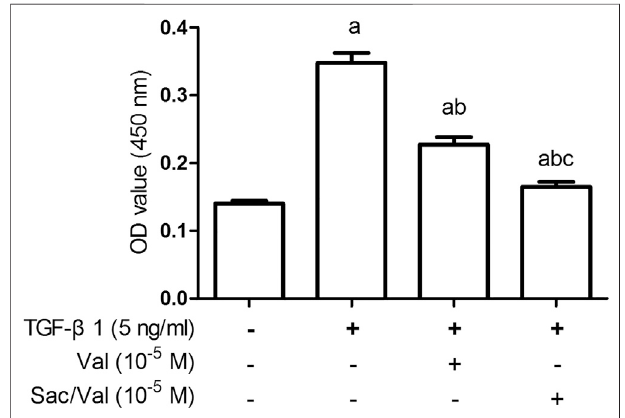
FIGURE 5 | Effects of sacubitril/valsartan on TGF- β 1-induced increased viability of myocardial fi broblasts under hypoxia conditions. MFs were inoculated in 96-well plates and replaced with 0.2%FBS when the cells grew to 60 – 70% con fl uence for 24 h. After sacubitril/valsartan (10 5 M) or valsarten (10 5 M) was added for 45 min, TGF- β 1 (5 ng/ml) was added for co- incubation in hypoxia environment for 48 h. Cell viability of MFs was detected by CCK-8 assay. OD, optical density; TGF- β 1, transforming growth factor- β 1; Val, valsartan; Sac/Val, sacubitril/valsartan. Results are mean ± SD ( n (cid:1) 8); a P < 0.05 vs. TGF- β 1 (0 ng/ml); b P < 0.05 vs. TGF- β 1 (5 ng/ml); c P < 0.05 vs.